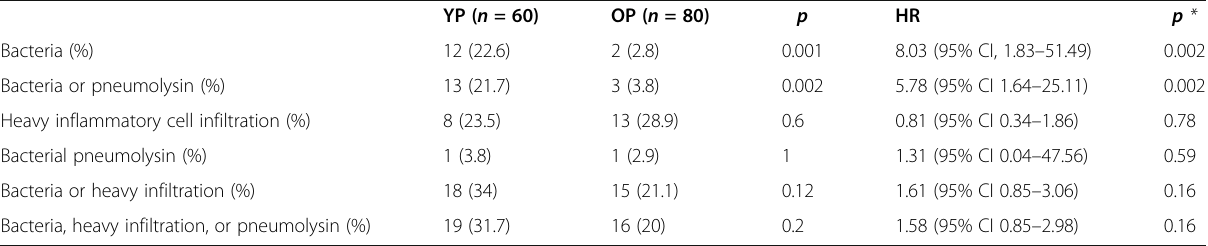
Table 4 Results of bacteria, pneumolysin, infiltration, and hazard ratio of young versus old patients YP ( n = 60) OP ( n = 80) p HR p * Bacteria (%) 12